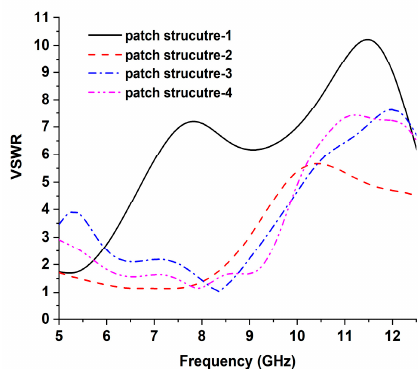
Figure 9. The effects of different radiating patch structures of antenna voltage standing wave ratio (VSWR). Table 3. Comparison of the radiating patch effects on voltage standing wave ratio.